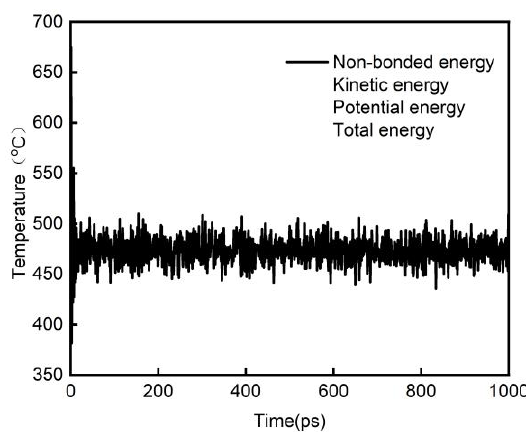
Figure 3. Temperature – time variation .